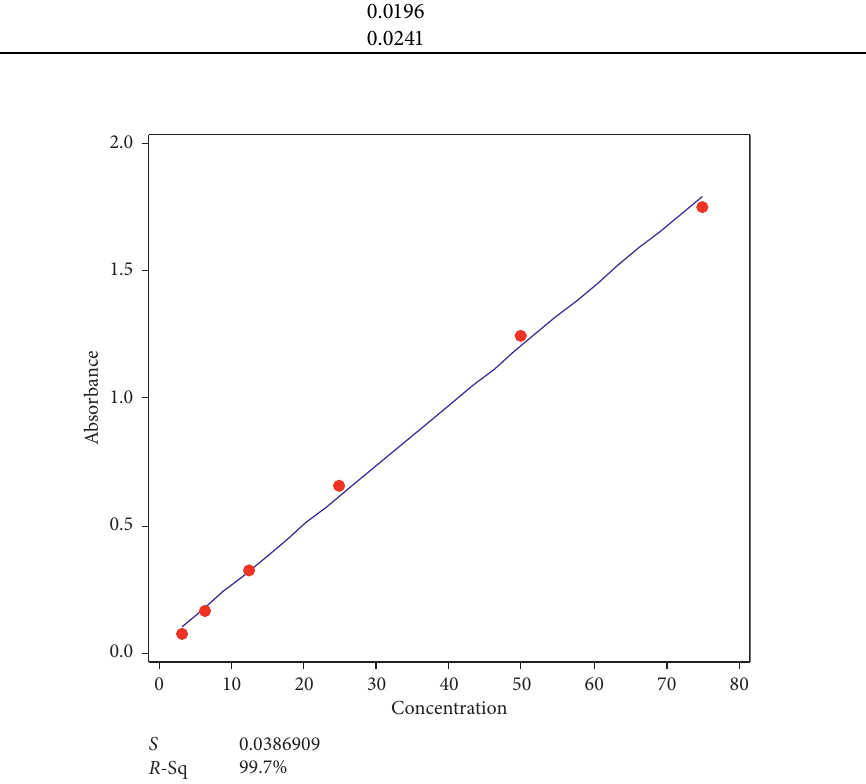
Figure 2: Standard curve of absorbance versus concentration of standard (bovine albumin) with 25% sulfosalicylic acid method. S : standard error of the estimate; R -Sq.: R -squared value; R -Sq. (adj.): adjacent R -squared value.